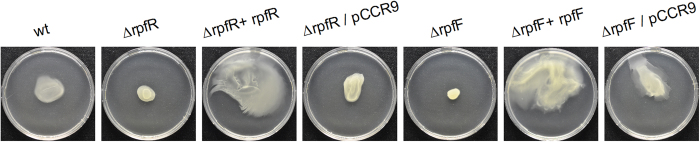
Overexpression of the RpfF/R QS-system increased swarming motility.Strains were spot inoculated on 0.4% NYG agar and plates were photographed after 24 h incubation.